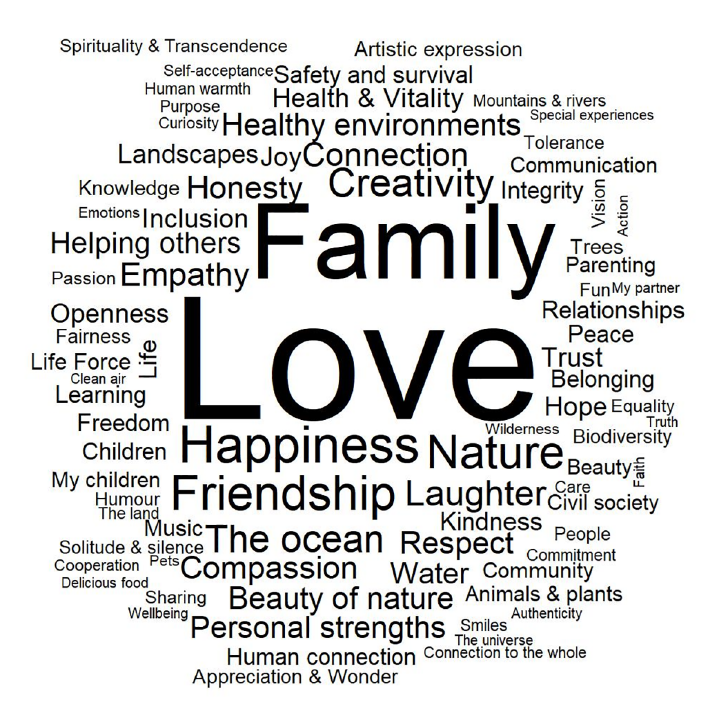
Figure 1. The infinite word